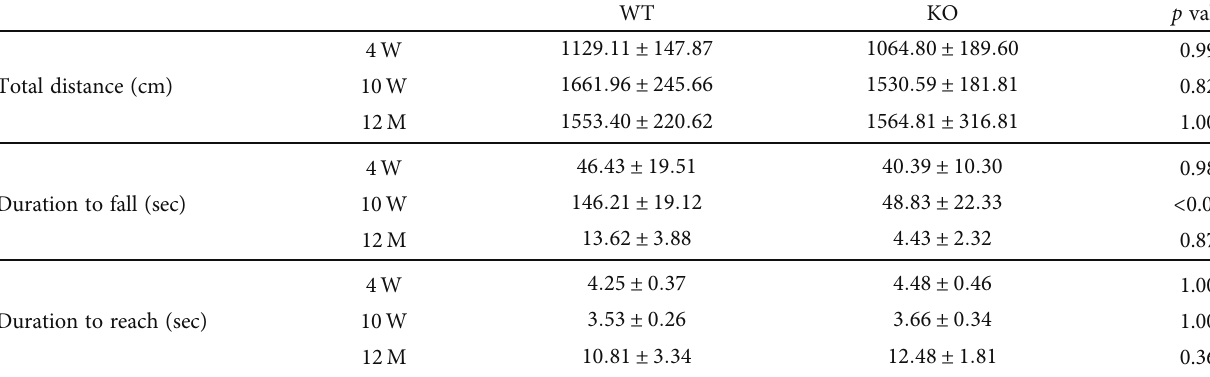
Table 3: Data from behavior